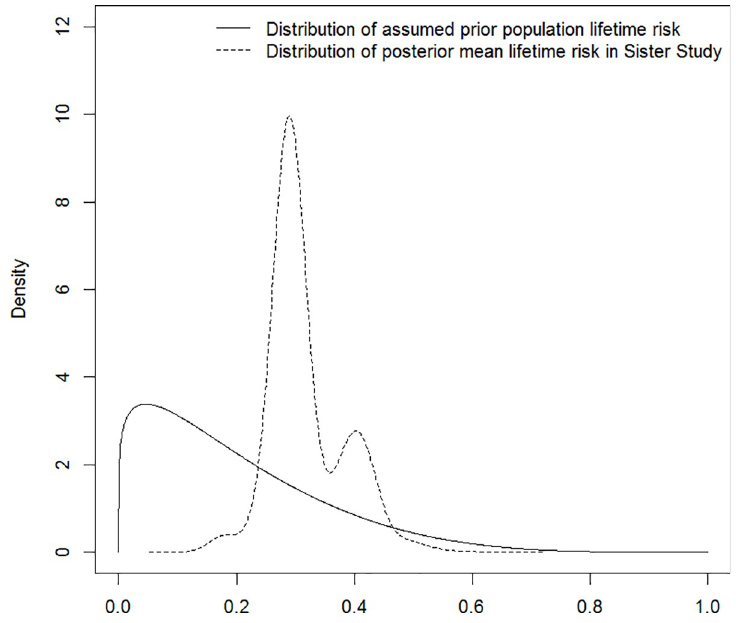
Fig 5. Distribution of assumed prior population pure lifetime breast cancer risk vs. the distribution of posterior mean pure lifetime breast cancer risk based on families participating in the Sister Study cohort.